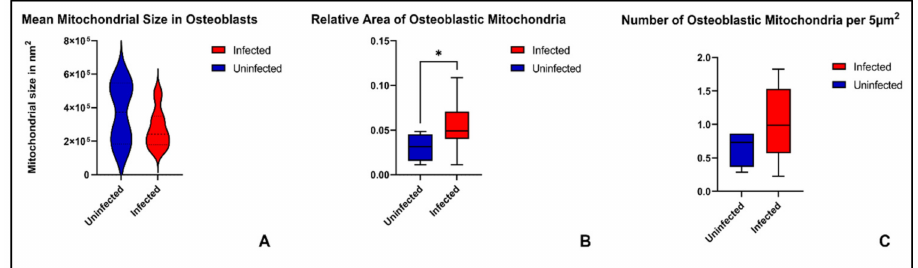
Figure 5. ( A ) Violin plot of mean mitochondrial sizes in osteoblasts, measured in nm 2 and showing no measurable difference between groups. ( B ) Box plot of relative cellular area occupied by mitochondria in osteoblasts showing significant increase in the infected group. * Indicates significant difference at p < 0.05. ( C ) Box plot of number of mitochondria per 5 µ m 2 in osteoblasts showing non-significant increase in the infected group.